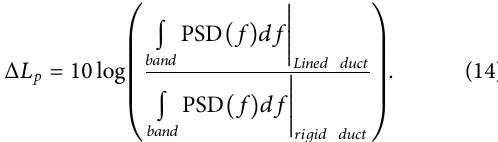
Frontiers in Materials |